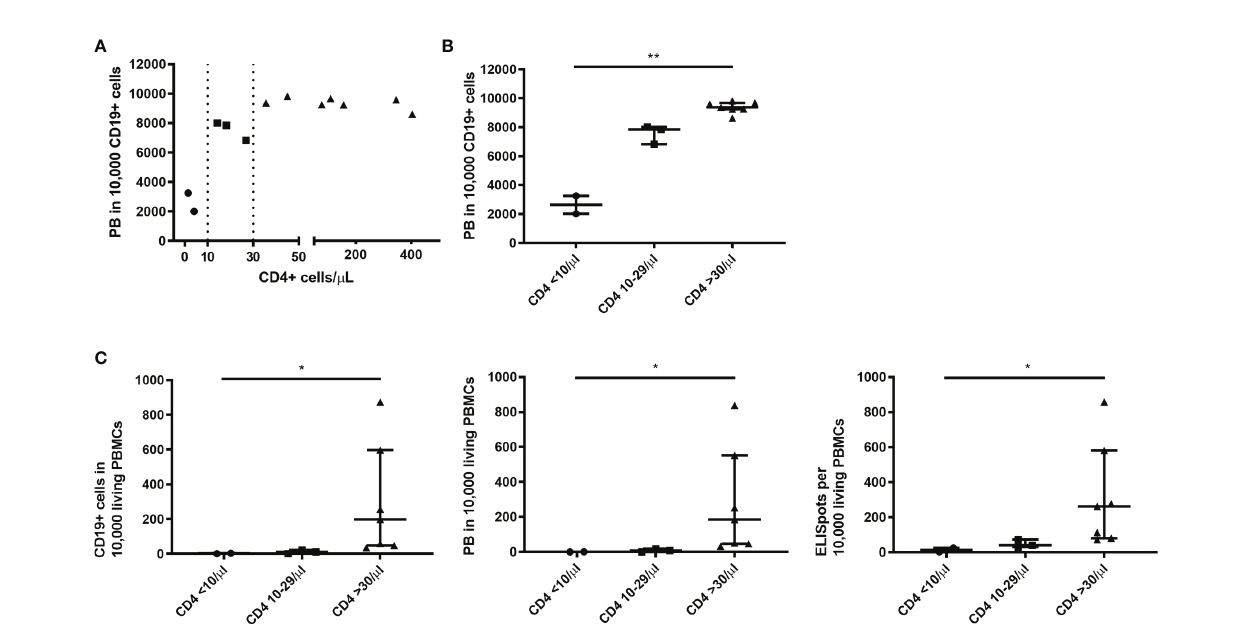
FIGURE 3 | Thresholds of 10 and 30 CD4+ T cells/µl were associated with an improved B cell function upon C/I/C stimulation. (A) A spearman correlation between the count of CD4+ T cells (cells/µl) ex vivo and the functional parameter PB/10,000 CD19+ cells revealed two thresholds of 10 cells/µl and 30 cells/µl, marked here with dotted lines. (B) Thresholds are highlighted by splitting samples into three groups according to the CD4+ count: CD4 <10/µl; CD4 10-29/µl; CD4 ≥ 30/µl plotted against PB/10,000 CD19+ cells. (C) Three groups of CD4+ counts plotted against other functional parameters: CD19+/10,000 PBMCs; PB/10,000 PBMCs; ISCs/ 10,000 PBMCs. (B, C) Bars represent median ± IQR. Groups were compared by Kruskal-Wallis-Test with *p < 0.05 and **p <